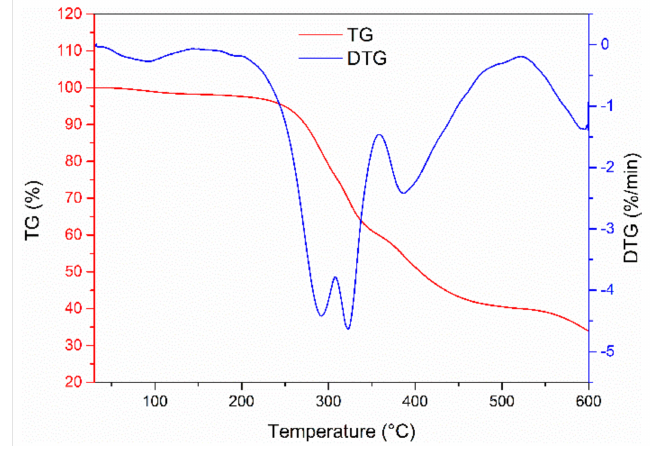
Figure 3. TG-DTG curve of the cured resin system.